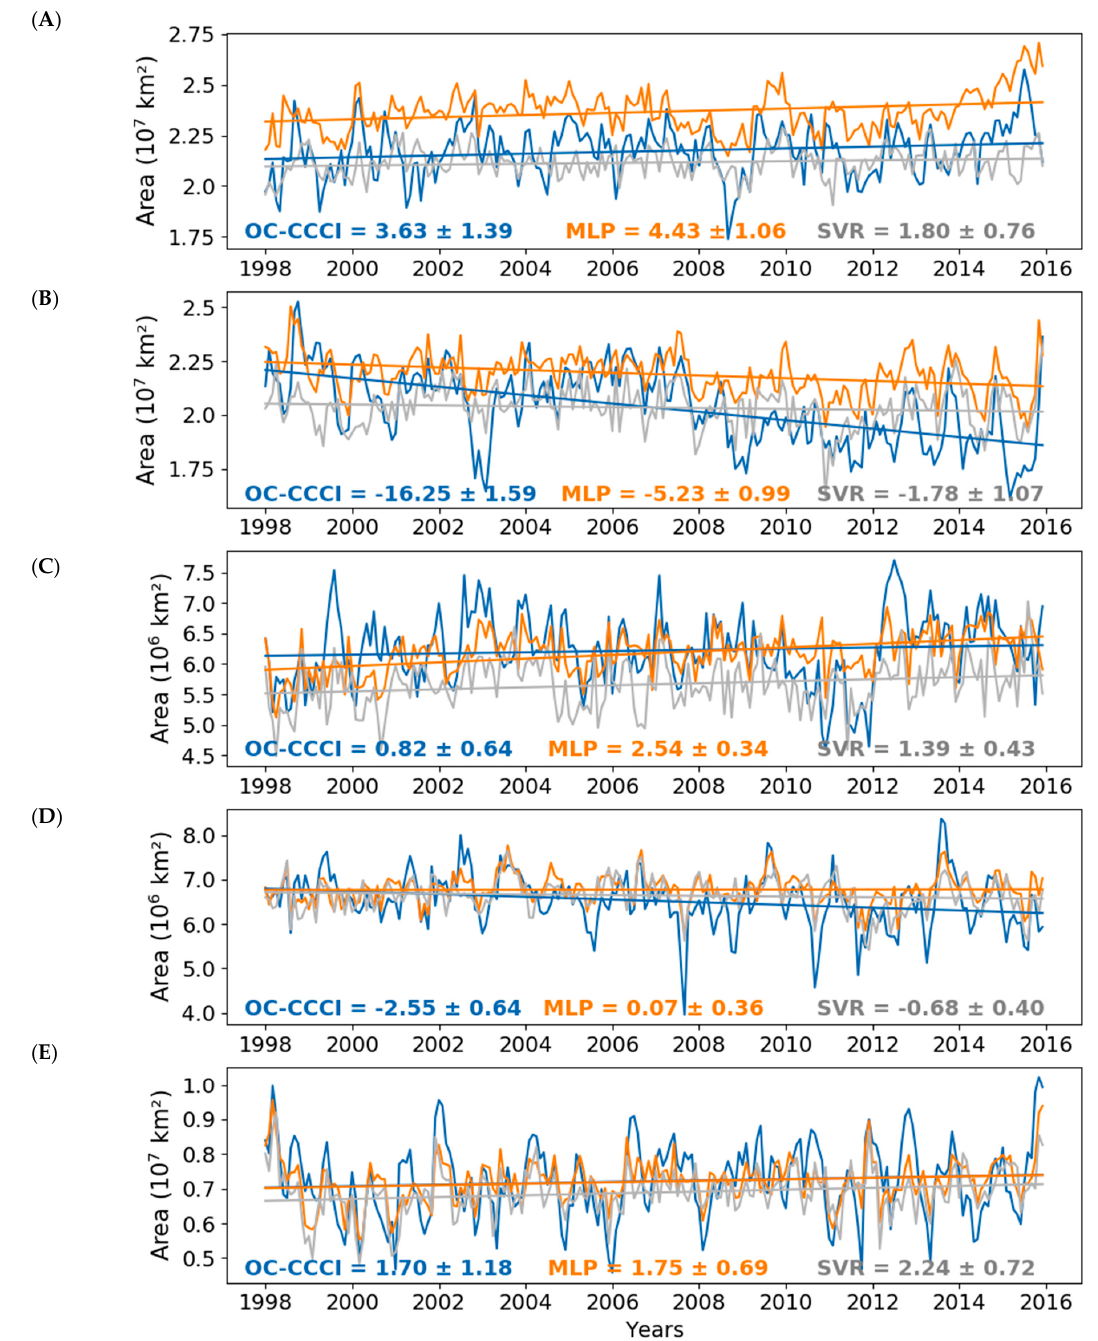
Figure 6. Time series of the monthly mean area (km 2 ) with surface Chl less than or equal to 0.07 mg.m − 3 between 5° and 45° N/° S latitude with the seasonal cycle removed in the ( A ) North Pacific, ( B ) South Pacific, ( C ) North Atlantic, ( D ) South Atlantic and ( E ) Indian Oceans. Chl OC-CCI is in blue, Chl SVR in grey and Chl MLP in orange. Straight lines are the linear trends calculated as in Figure 5. The average trends and standard deviation are also indicated.